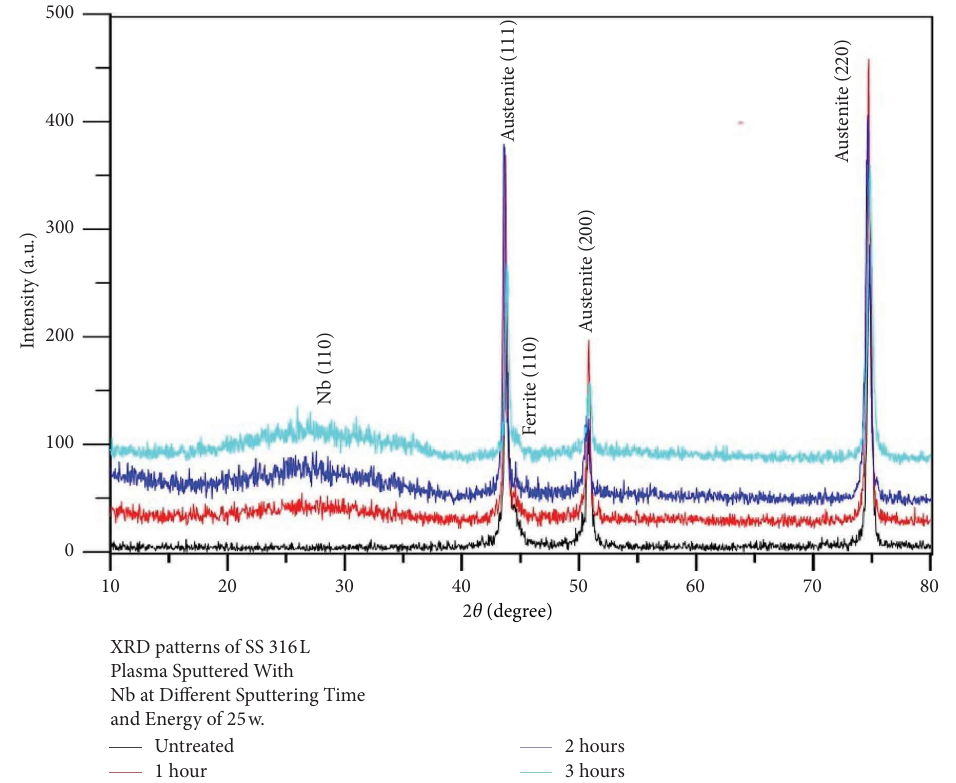
Figure 1: XRD patterns of 316L SS plasma sputtered with Nb at diferent sputtering times.